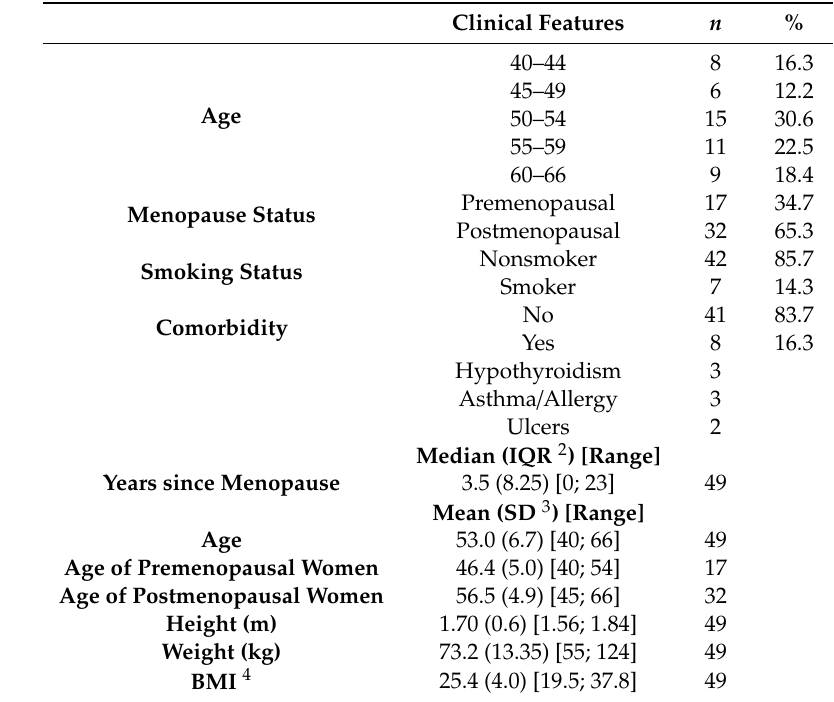
Table 1. Demography of 49 female blood donors 1